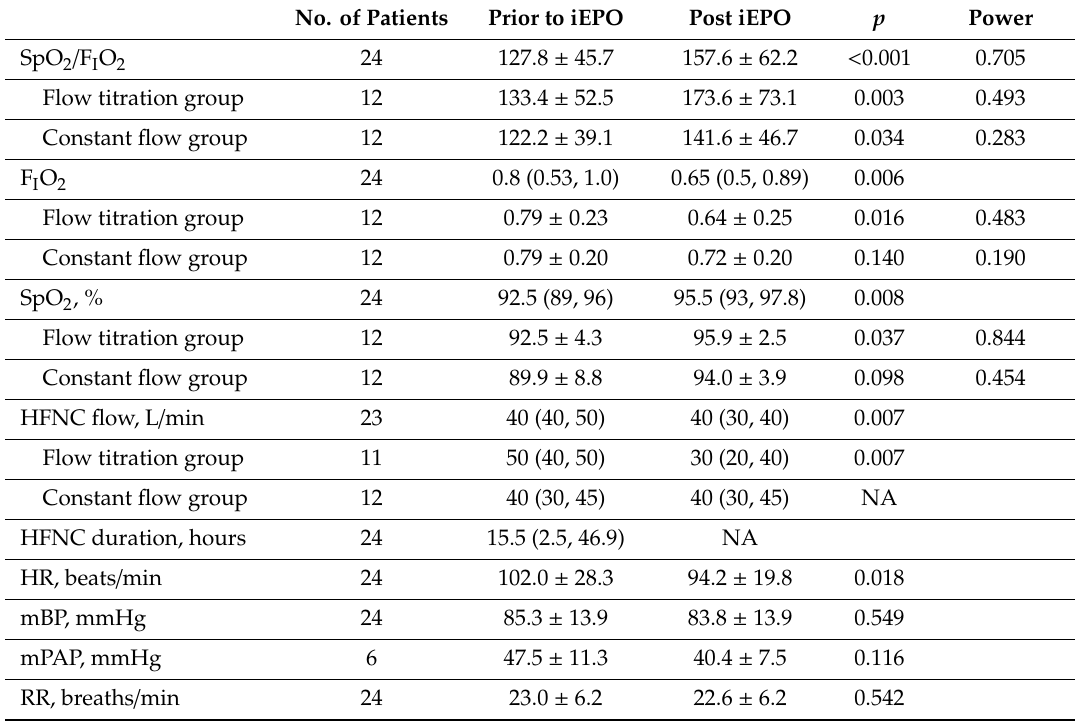
Table 4. Comparison of parameters and oxygenation responses pre and post iEPO for 24 patients with concomitant refractory